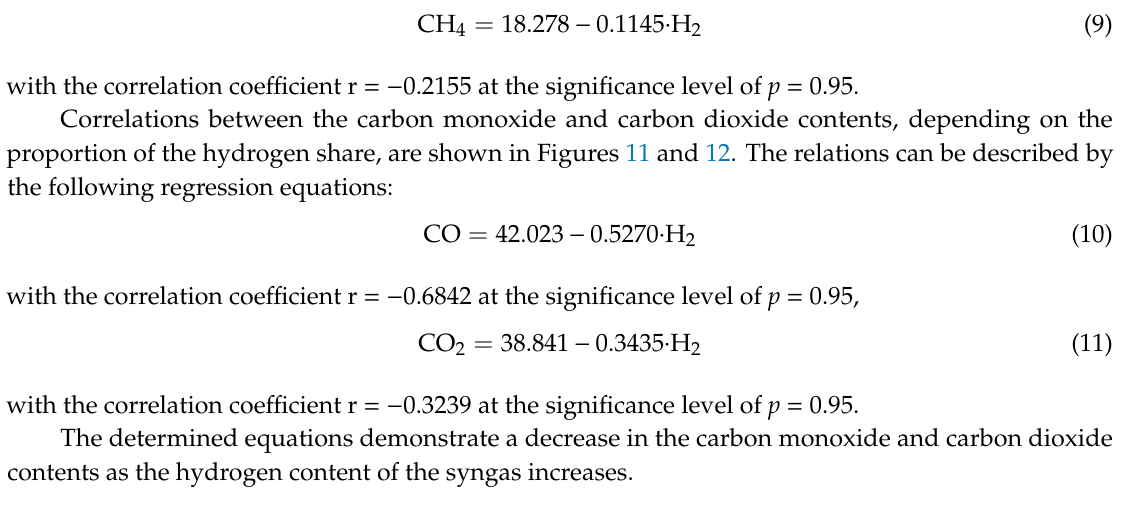
Figure 10. Correlation between the percentage content of CH 4 and H 2 .